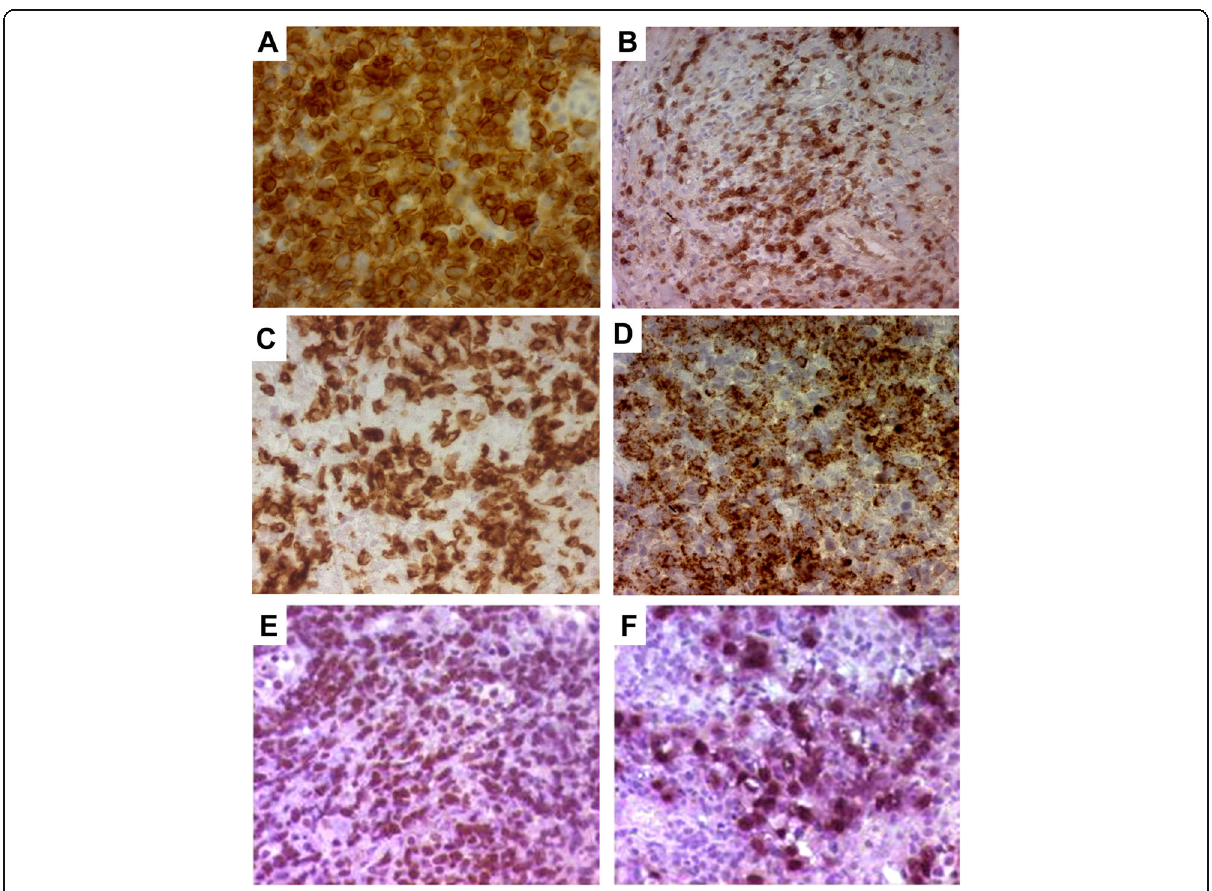
Fig. 2 Immunohistochemical characteristics of extranodal NK/T-cell lymphoma. a CD3 expression (original magnification, ×400). b CD5 expression (original magnification, ×400). c Expression of CD56 (original magnification, ×400). d Granzyme B immunostaining of tumor cells (original magnification, ×400). e Positive LMP-1 immunostaining (original magnification, ×400). f EBER-positive tumor cells detected by in situ hybridization (original magnification,